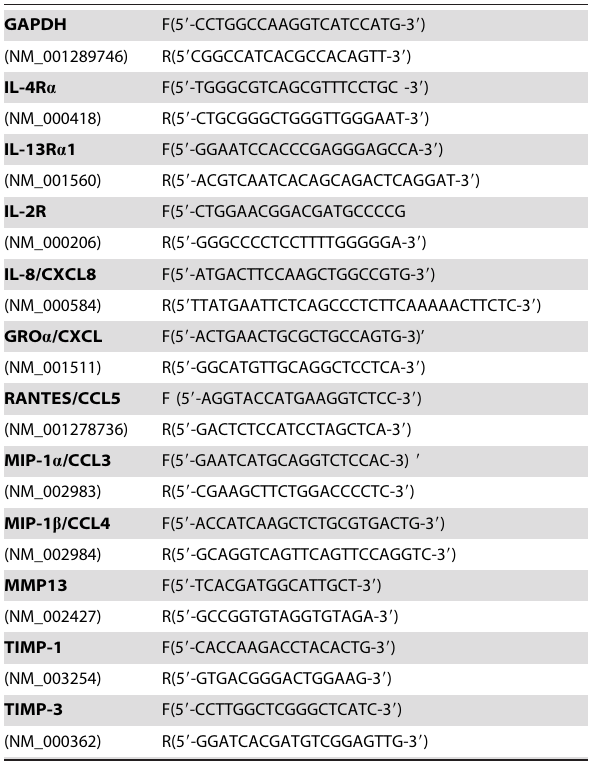
Table 1. Primers for PCR